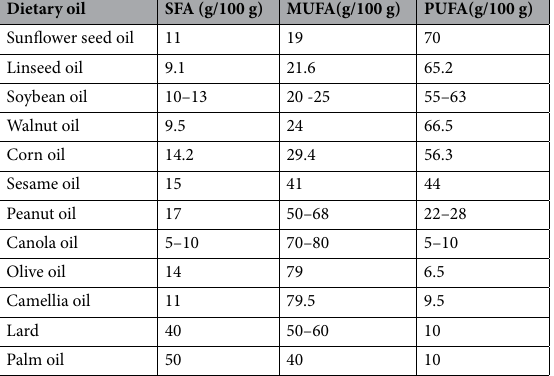
Table 1. The content of SFA, MUFA, PUFA in dietary oil, all data are from the manufacturer’s label on the